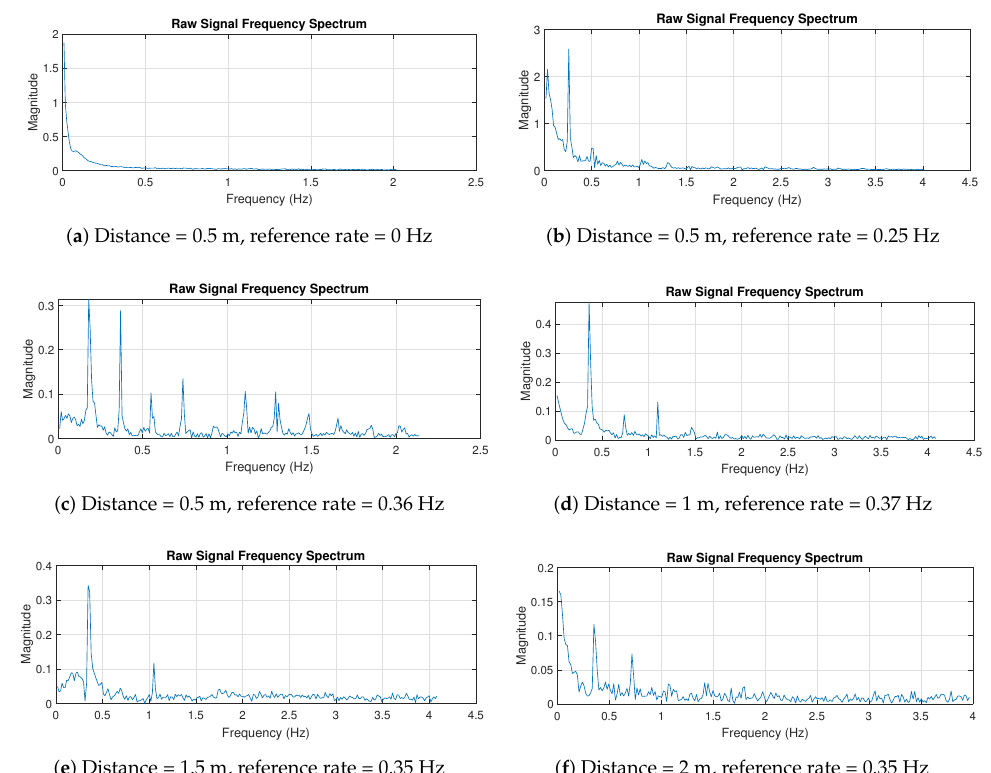
Figure 10. Experiment 1 results in frequency domain.